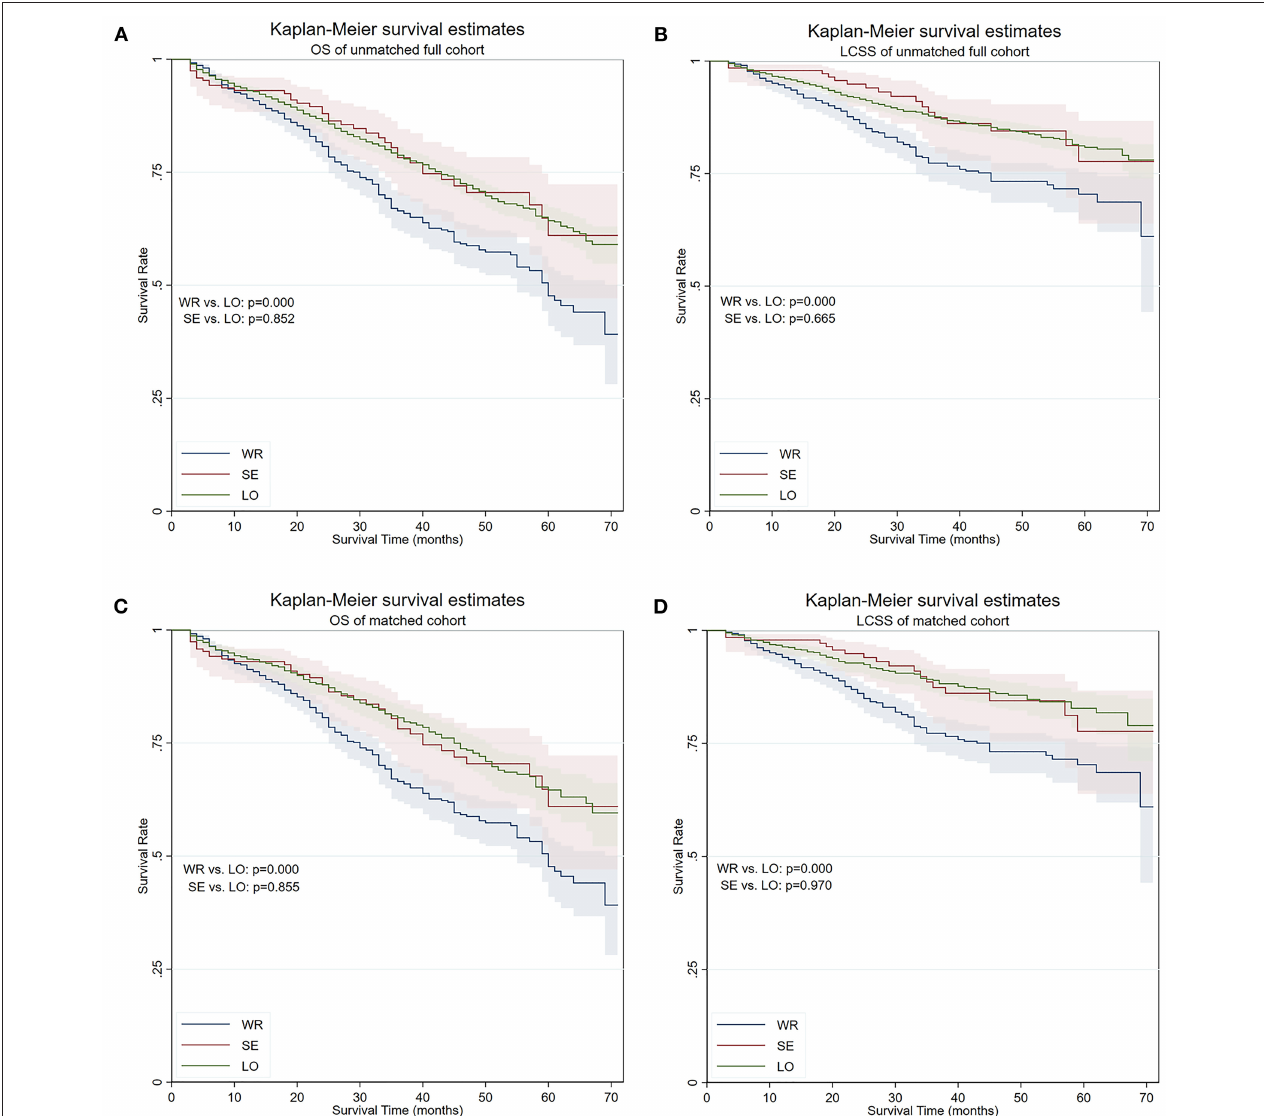
FIGURE 1 | OS and LCSS of the full cohort and PS-matched cohort. (A) OS of the full cohort. (B) LCSS of the full cohort. (C) OS of the PS-matched cohort. (D) LCSS of the PS-matched cohort. OS, overall survival; LCSS, lung cancer–specific survival; PS, propensity score; WR, wedge resection; SE, segmentectomy; LO, lobectomy.